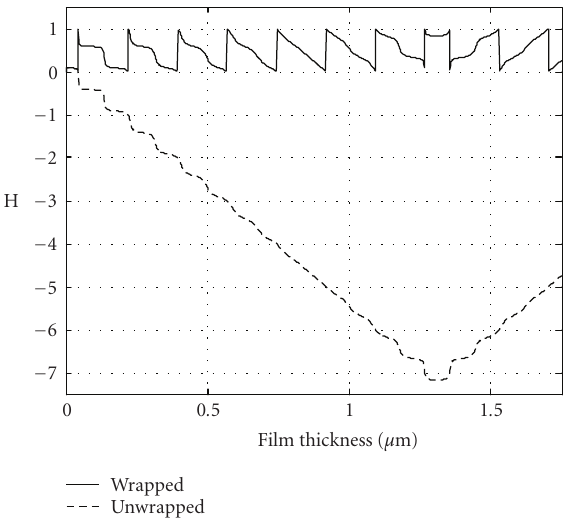
Figure 2: Example of phase wrapped and unwrapped hue values as a function of film